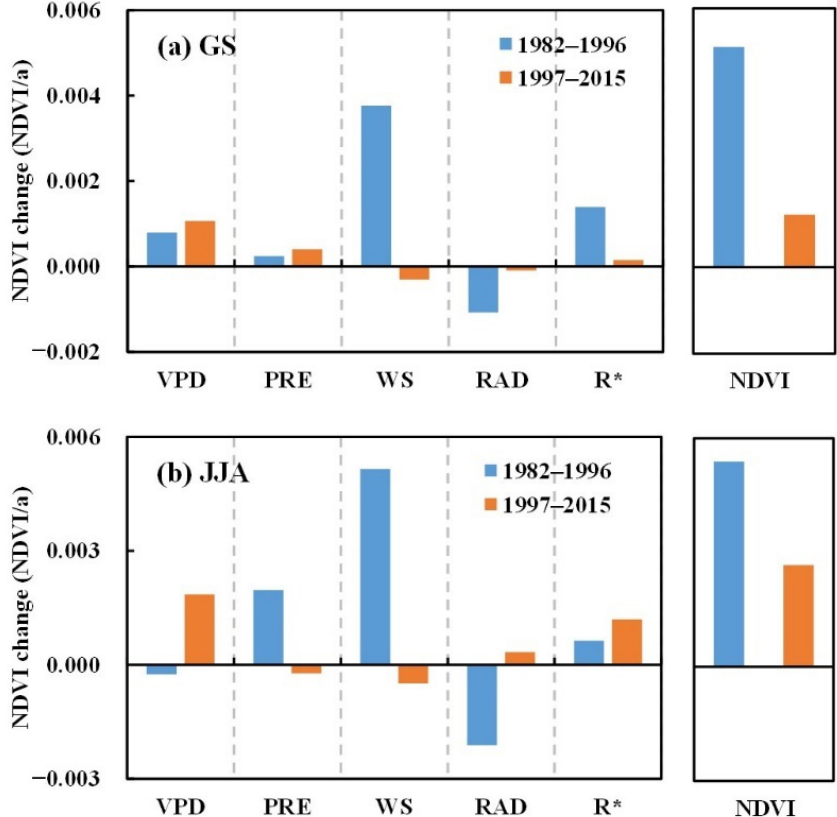
Figure 12. Individual contributions of selected climate variables to NDVI changes over the GS ( a ) and JJA season ( b ) during the two periods. Four climate variables are included: VPD, precipitation, wind speed, and sunshine. The figure to the right illustrates the NDVI changes of the two periods. During the 1982–1996 period, an overall decrease in wind speed played an important role in greening over the growing season and summer season in the Xinjiang region, regions of Xinjiang. Notably, the sunshine duration negatively affected NDVI, and